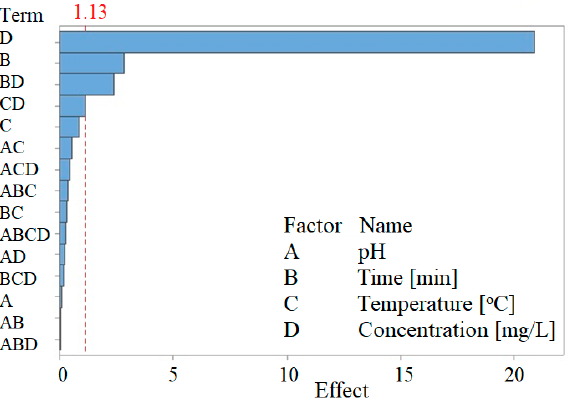
Figure 5. Pareto diagram—effect of the control parameters on adsorption capacity. The regression equation in non-coded units is CapAds = − 1.207 + 0.06598 A + 0.009908 B + 0.03695 C + 0.1081 D − 0.001356 AB –